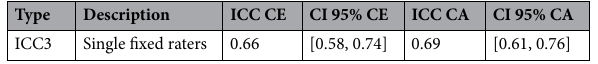
Table 3. ICC for the CE and CA for trained raters.